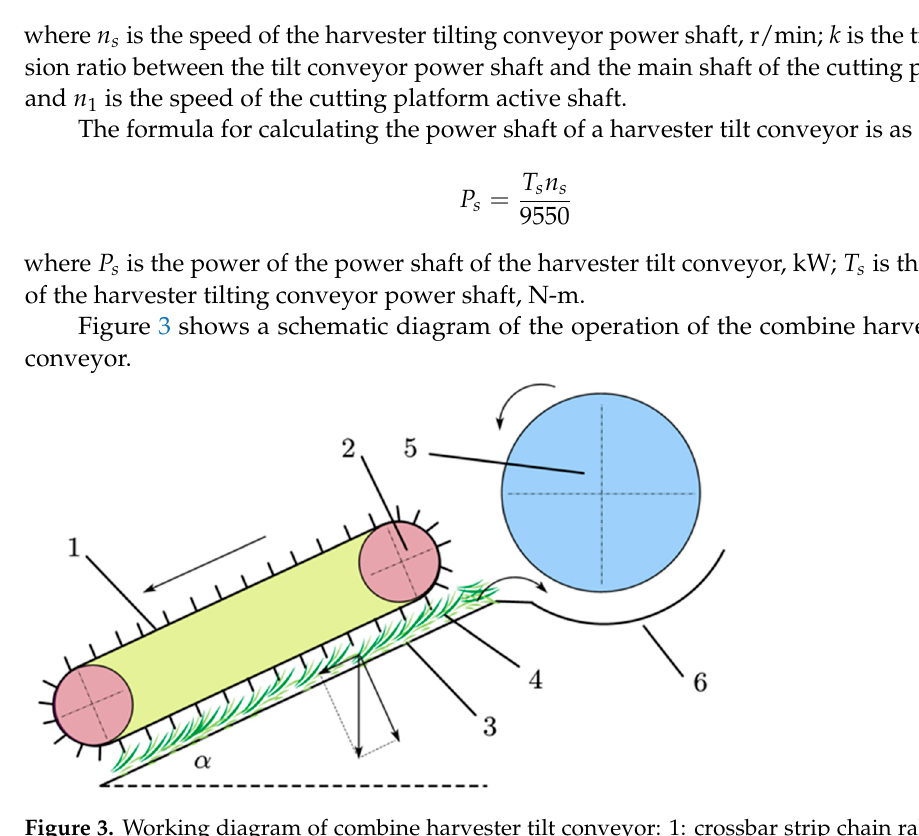
Figure 3. Working diagram of combine harvester tilt conveyor: 1: crossbar strip chain rake, 2: tilt conveyor active shaft, 3: tilting conveyor bottom plate, 4: straw, 5: threshing drum, 6: concave plate.